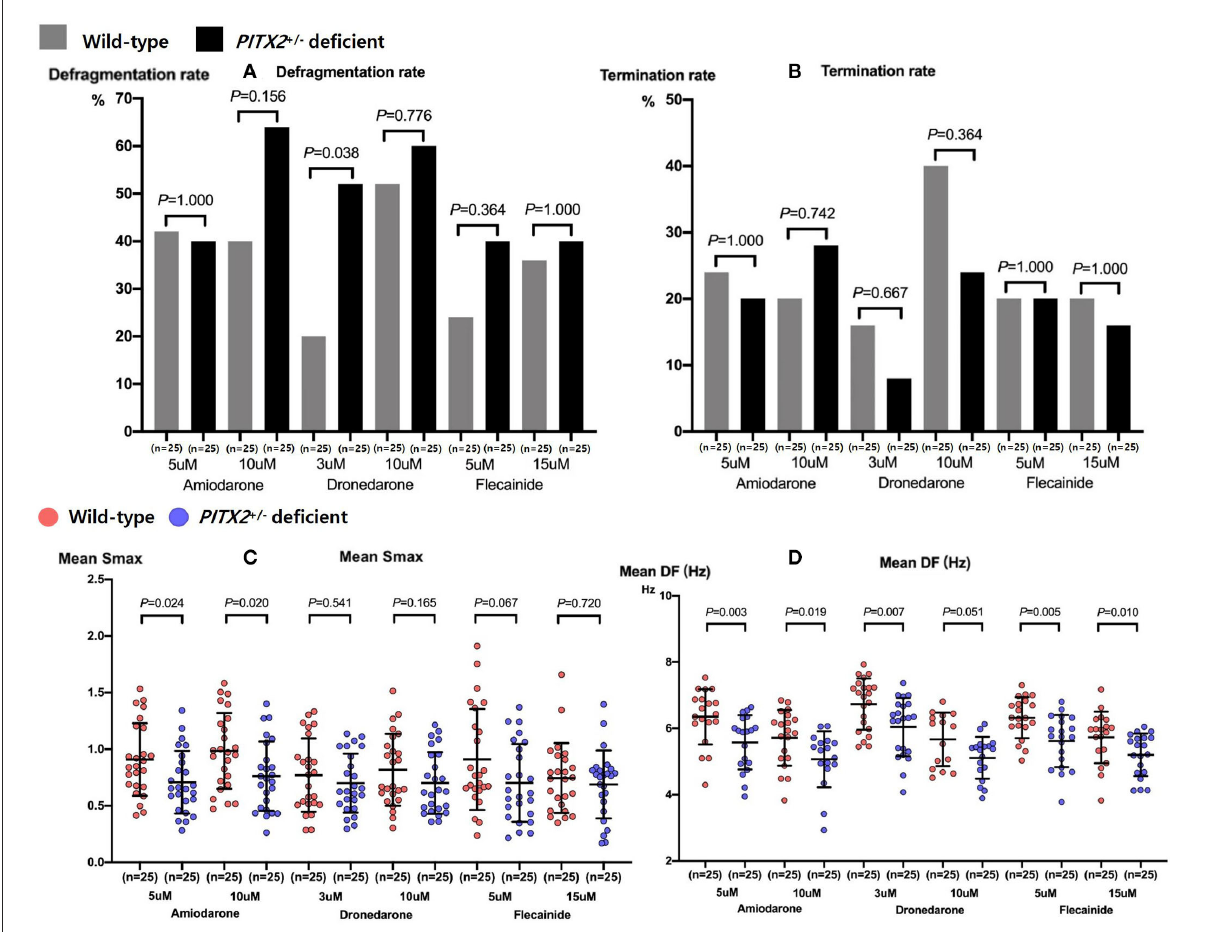
FIGURE4 Genotype-dependent comparisons of the AF defragmentation (A) and AF termination (B) rates, mean Smax (C) , and DF (D) depending on the high and low doses of the three types of AADs. Every group includes identical number of samples ( n = 25). Smax indicates the maximal slope of the restitution curves; DF, Dominant frequency; PITX2 , paired-like homeodomain transcription factor